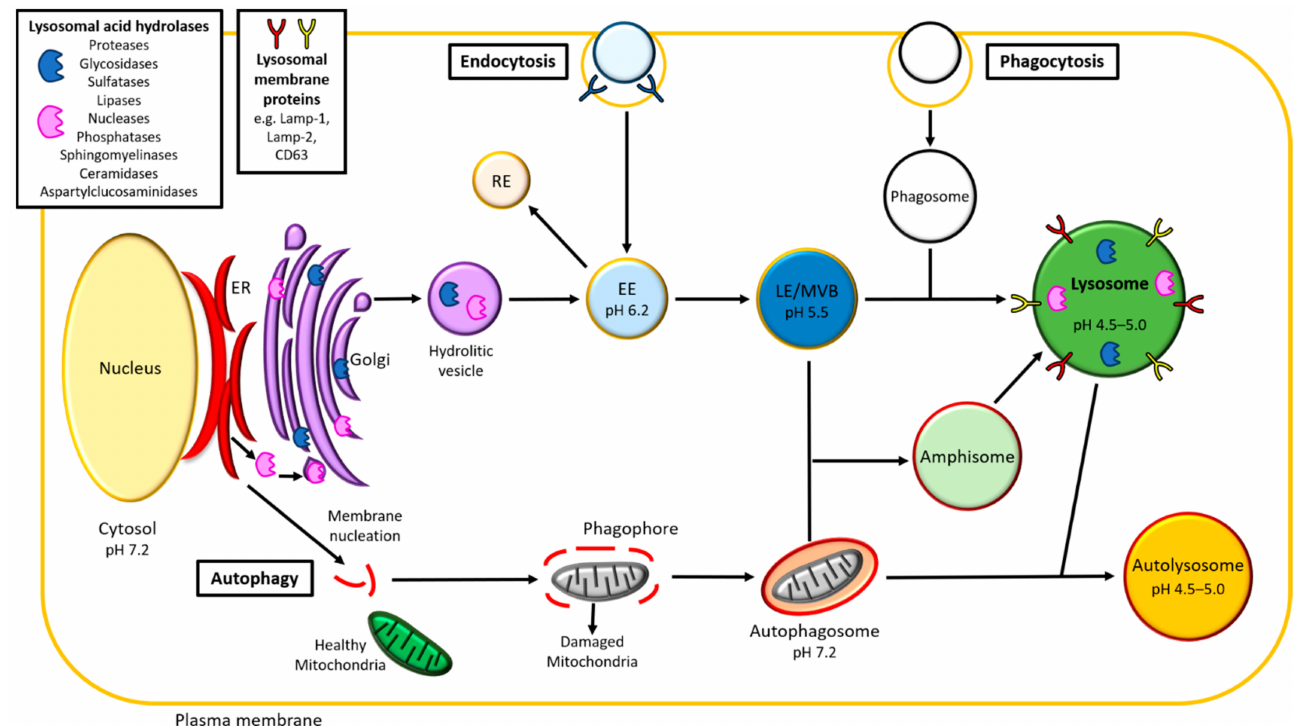
Figure 1. Endolysosomal and autophagic pathways. Schematic view of the main cellular pathways involved in Lysosomal Storage Diseases. As summarized by the figure, endolysosomal and autophagic pathways are the most important processes regulating the degradation and recycling of intracellular materials. These two pathways converge to the final step of lysosomes (green) formation. EE, early endosome (light blue); LE, late endosome (blue); MVB, multivesicular body (blue); RE, recycling endosome (light yellow); ER, endoplasmic reticulum (red); Golgi (violet); amphisome (light green); autolysosome (orange); healthy mitochondria (dark green); damaged mitochondria